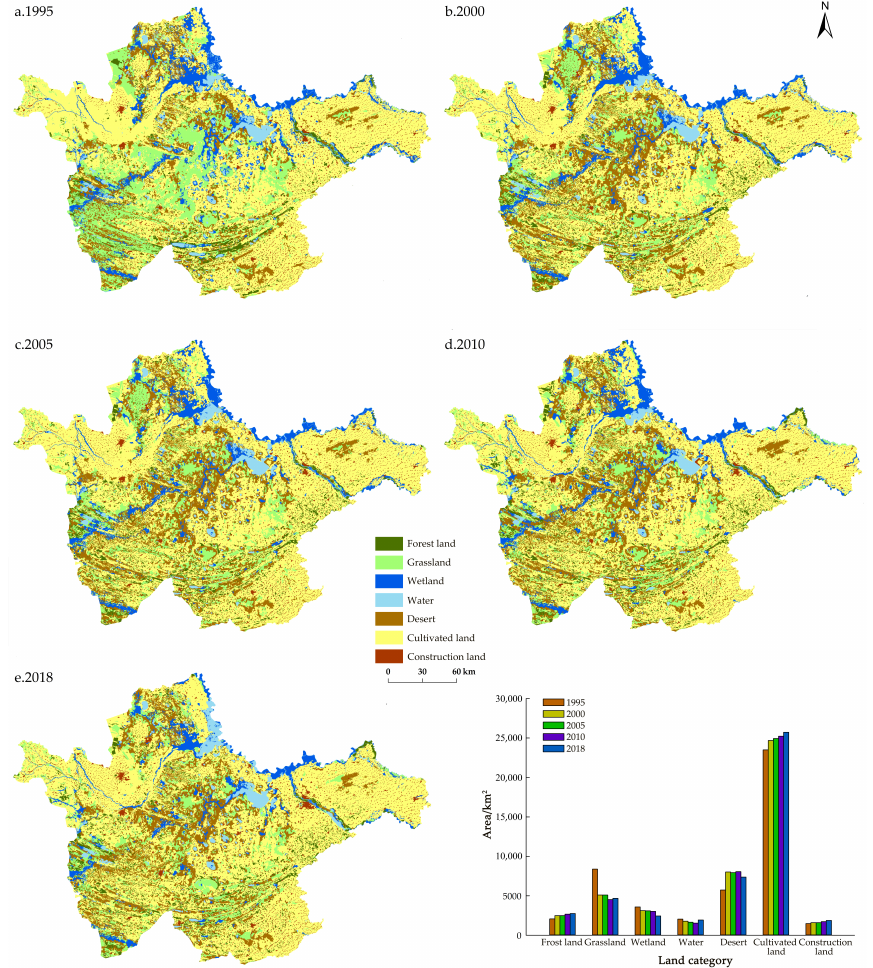
Figure 7. The land use situation in Western Jilin from 1995–2018.